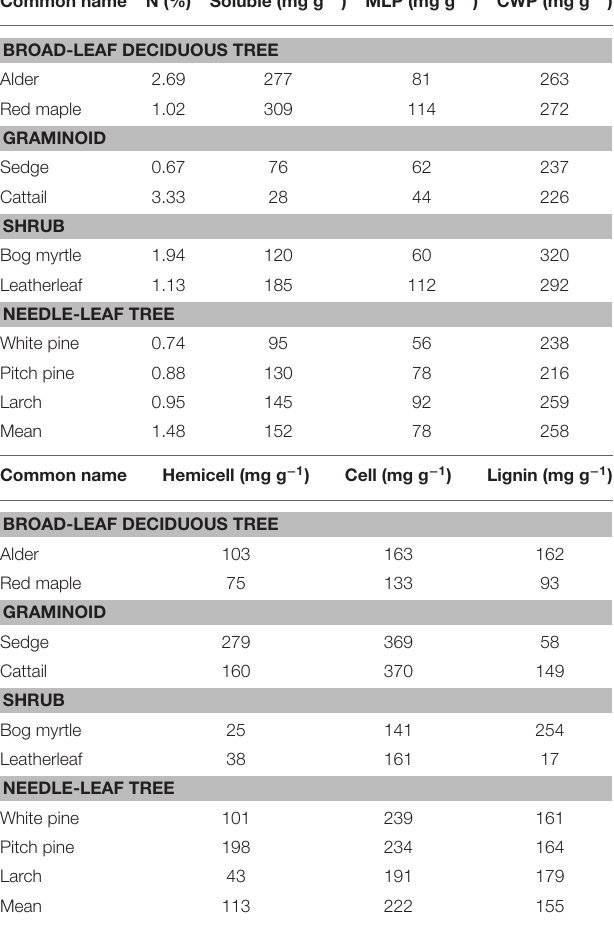
TABLE 3 | Cell wall composition of leaf litter.